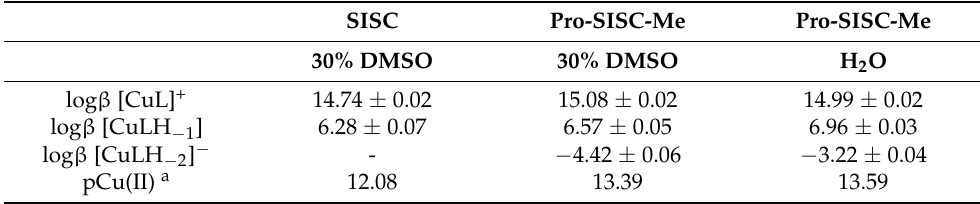
Table 2. Overall stability constants ( β ) of the Cu(II) complexes formed with SISC and Pro-SISC-Me determined by pH-potentiometry in 30% ( v / v ) DMSO/H 2 O and in water in addition to pCu(II) ( − log[Cu(II)]) values calculated at pH 7.4 at c Cu(II) = 1 µ M and c ligand = 10 µ M. HL is the neutral form of the ligands. ( T = 25 ◦ C, I = 0.10 M (KCl)). SISC Pro-SISC-Me Pro-SISC-Me 30% DMSO 30% DMSO H 2 O log β [CuL]